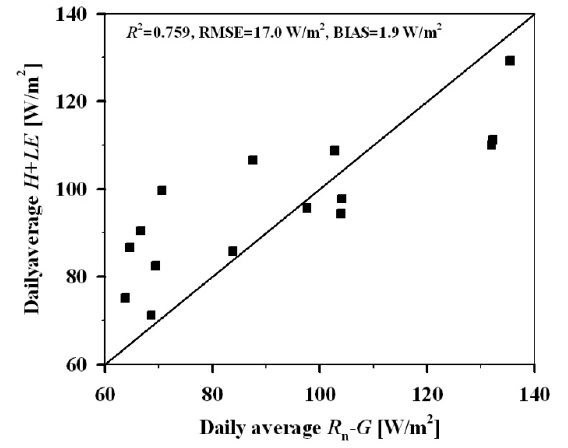
Figure 13. Closure of energy balance from EC measurements at daily